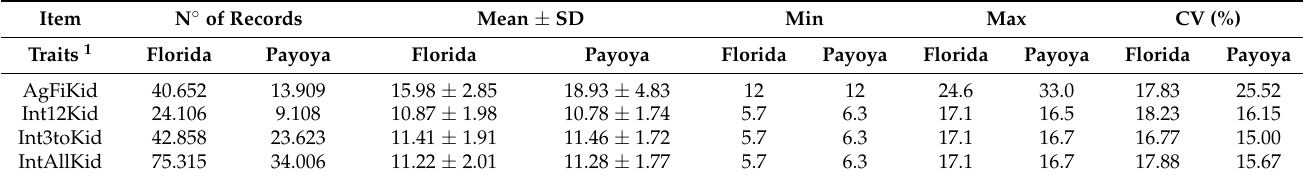
Table 1. Basic descriptive statistics for fertility traits in Florida and Payoya breeds.